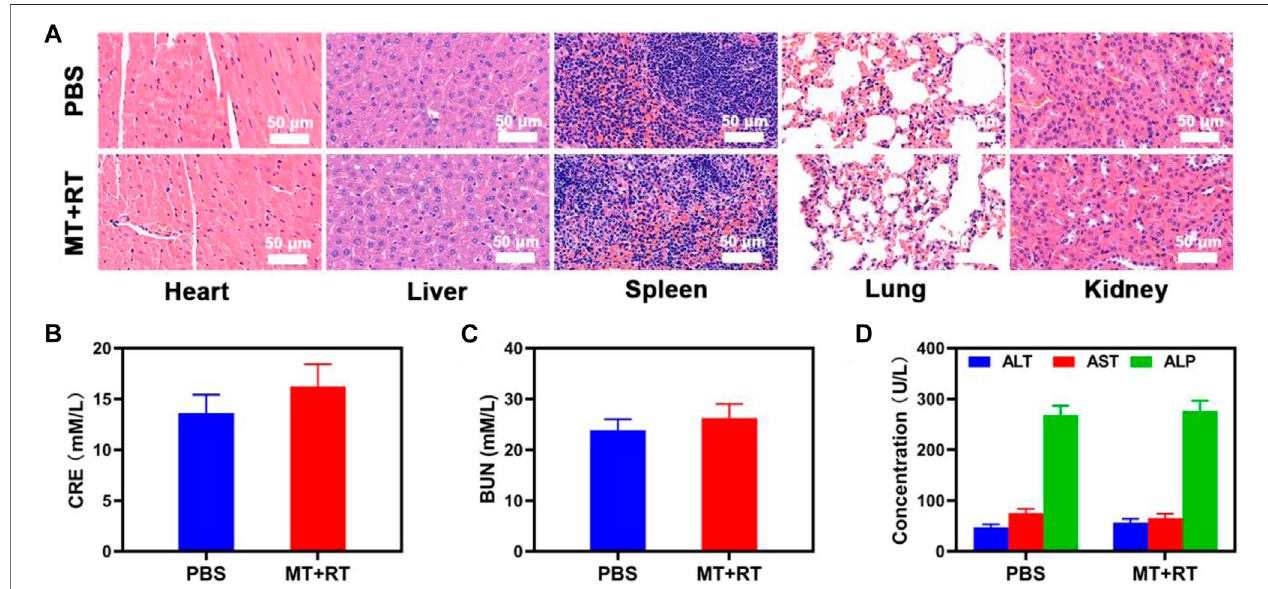
FIGURE 4 | (A) Histopathological analyses of major organs (liver, spleen, kidneys, lungs, heart) from tumor-bearing mice were conducted after PBS or MT + RT treatment (B – D) . Analyses of blood biochemistry were conducted in the indicated miceto measure levels of (B) CRE, (C) BUN, and (D) the liver functional markers ALT, ALP, and